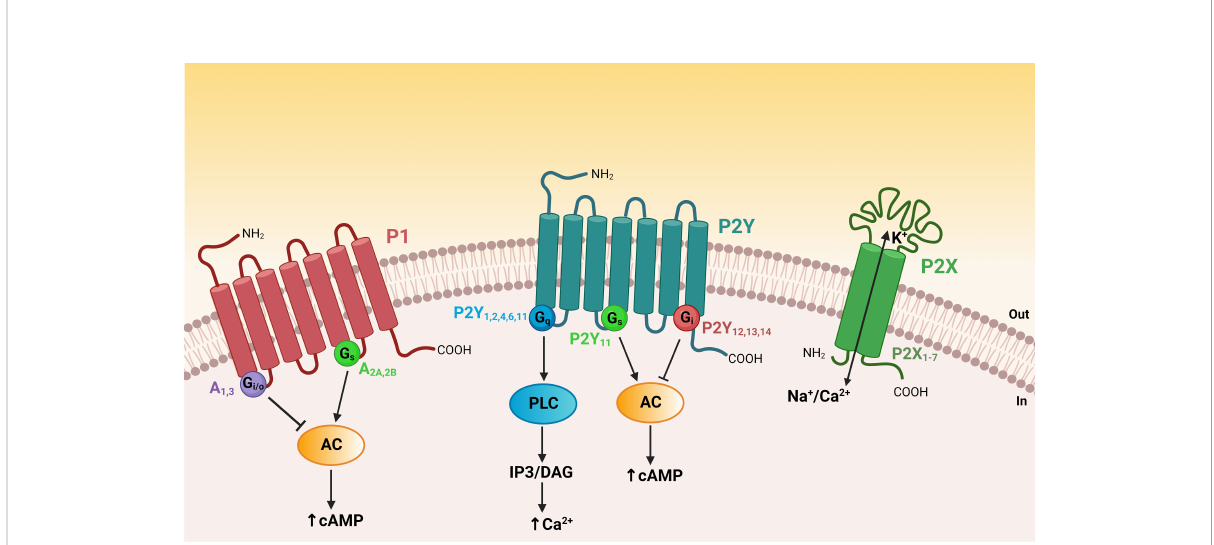
FIGURE 2 Topology of purinergic receptors and intracellular signaling pathways. The P2X receptors have two transmembrane domains with both their N- and C-termini on the cytoplasmic side of the plasma membrane. Activation of P2X receptors by extracellular ATP opens a non-selective cation channel, resulting in calcium and sodium in fl ux or potassium ef fl ux. P1 and P2Y receptors are GPCRs possessing seven transmembrane domains with an extracellular N-terminus domain and an intracellular C-terminus domain. P2Y1-like receptors (P2Y 1,2,4,6,11 ) are coupled to G q and their activation leads to phospholipase C (PLC) activation, generation of IP3 and DAG, and intracellular Ca 2+ release. The P2Y11 receptor couples to both G q and G s to increase intracellular Ca 2+ and cAMP. P2Y12-like receptors (P2Y 12,13,14 ) are coupled to G i and thus reduce intracellular cAMP levels through inhibition of adenylyl cyclase (AC). Adenosine P1 receptors differentially regulate the intracellular concentration of cAMP. A1 and A3 receptors are coupled to G i/o and induce a diminution in cAMP levels, whereas A2A and A2B receptors are coupled to G s and their activation leads to an elevation in intracellular